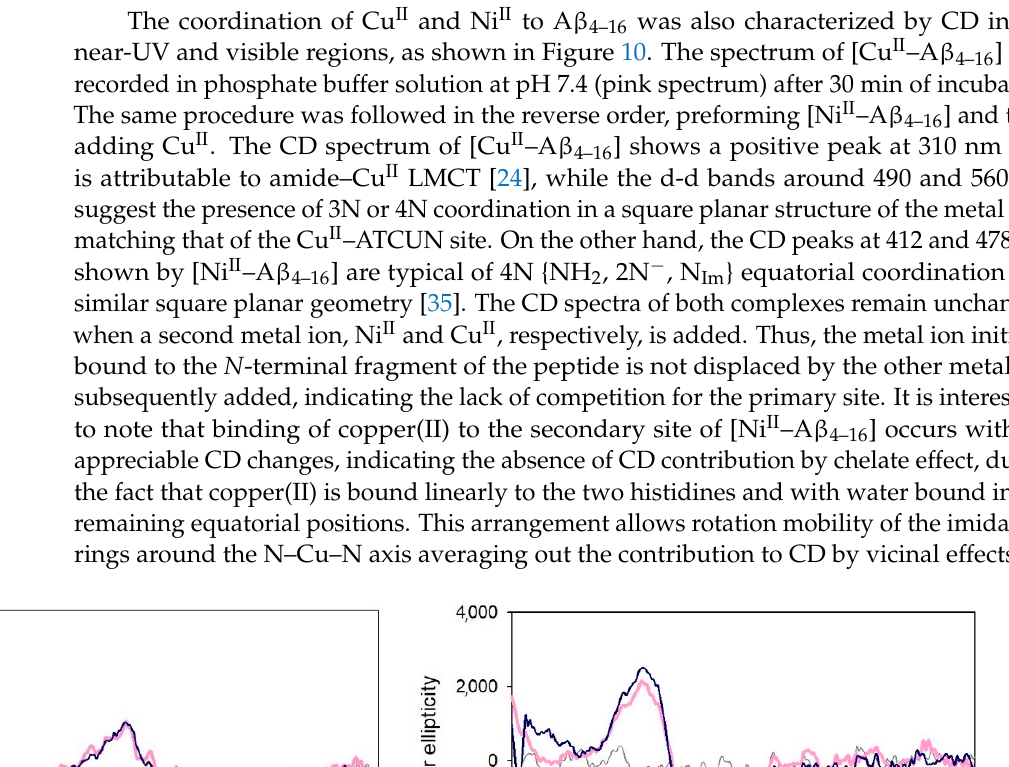
Figure 9. Far-UV CD spectra of A β 4–16 peptide (10 µM) in 5 mM phosphate buffer solution at pH 7.4 (blue trace) and upon the addition of Ni II (9.5 µM), after few seconds of incubation (light blue) and 15 min (green). Then, 1 (pink) and 2 equiv. of copper(II) (grey) were added to the Ni–A β 4–16 complex.